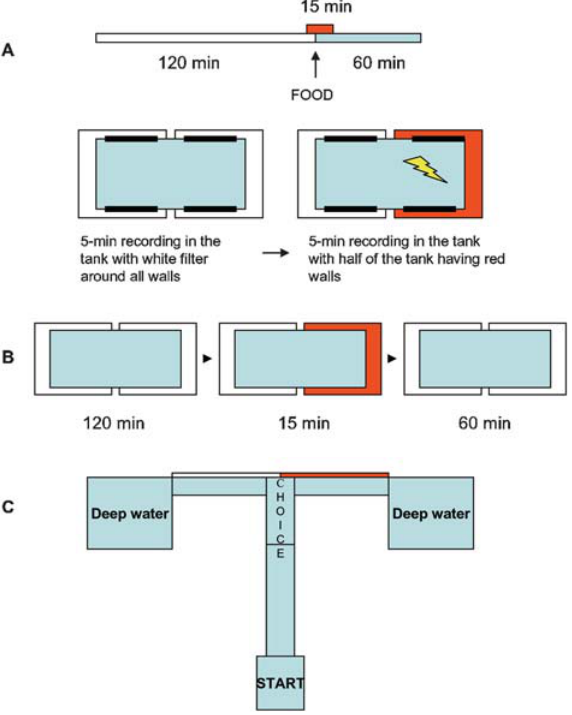
Figure 1. Schematic illustrations of the methodological approaches used. A. Time schedule of CPP procedure: 120 min of baseline recording without food in all-white tank, followed by 60 min of recording after food administration. Red color was present for 15 min, starting 5 min prior to food administration. B. CPA procedure: Each day, zebrafish behavior was recorded first in the test tank with all white walls (5 min), then for 5 min after half of the tank walls changed to red color. Horizontal black bars - stimulating electrodes. Electric shock (yellow ‘‘lightening’’) delivered only in the red zone. C. T-maze with Start and Choice zones, inserted color filters and deep water end compartments. The apparatus (30 mm water level) included a starting zone, 40 6 30 mm, separated from the rest of the maze by a transparent removable partition. Behind the partition, there was a long 80 6 20 mm arm and two short 60 6 20 mm arms, which lead to the removable deep water chambers (85 mm water level).